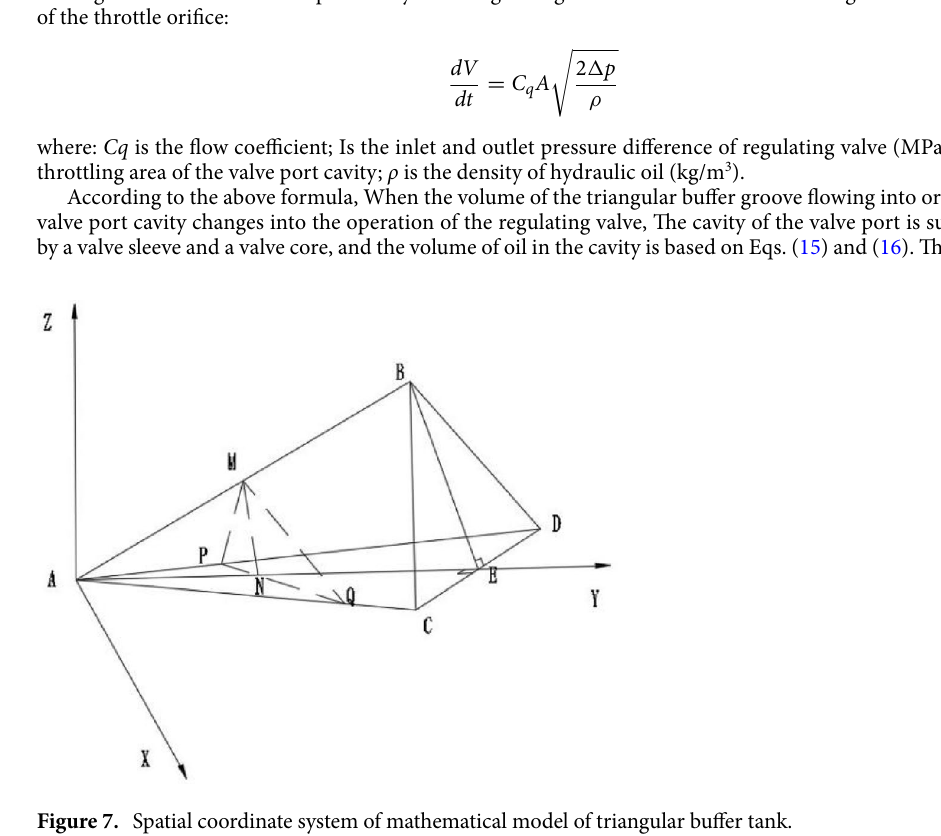
Figure 7. Spatial coordinate system of mathematical model of triangular buffer